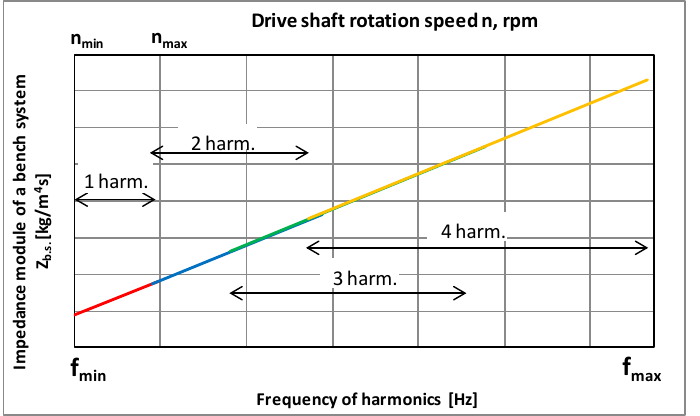
Figure 16. Impedance module of a bench inertia system with a pipeline at the pump output. Analysis of Figure 16: the impedance module of the bench system has a linear character and depends mainly on the “inertial” impedance of the ImZ pl pipeline (i.e., reactive losses in the